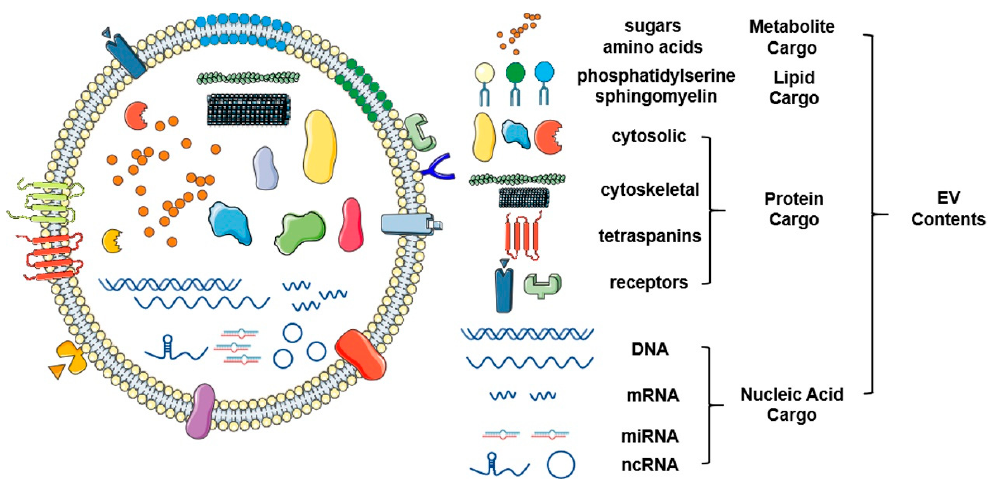
Figure 2. Schematic representation of the structure and contents of extracellular vesicles. Extracellular vesicles are a class of small vesicles encapsulated with a bilayer of lipid that surrounds a variety of functional molecular contents, such as proteins, nucleic acids, and lipids. As novel omics technologies continue to develop, a large scale of screening and identification of extracellular vesicles (EV) contents will continue to mature. This figure was created with Smart Servier (https://smart.servier.com) and BioRender.com.